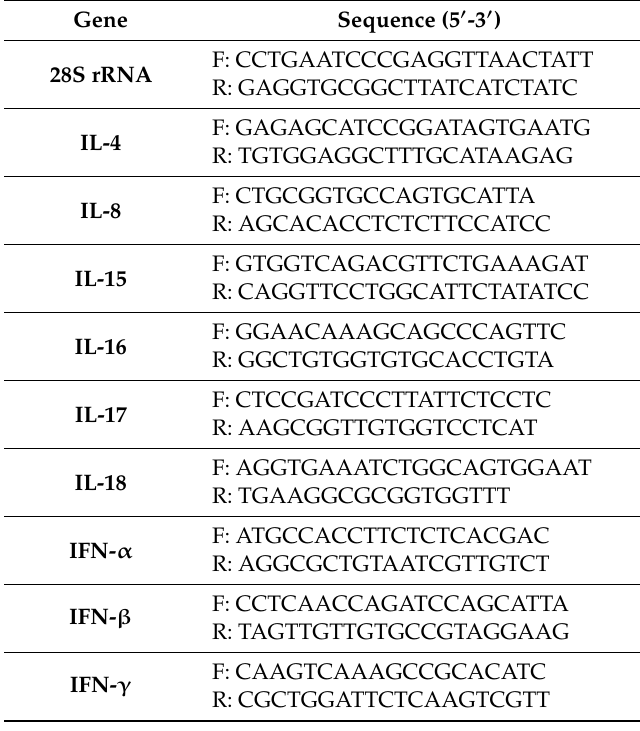
Table 2. Primer sequences used in the real-time RT-qPCR